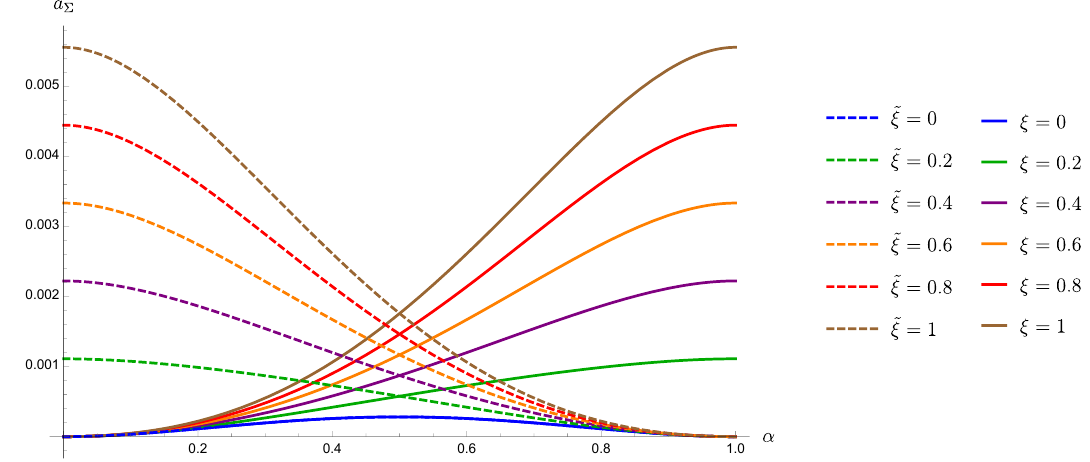
Figure 4 . Behavior of a Σ as a function of α for a monodromy defect in a theory of a single conformally coupled complex scalar in d = 6 . The solid lines have fixed ˜ ξ = 0 with varying ξ , and the dashed lines have fixed ξ = 0 with varying ˜ ξ